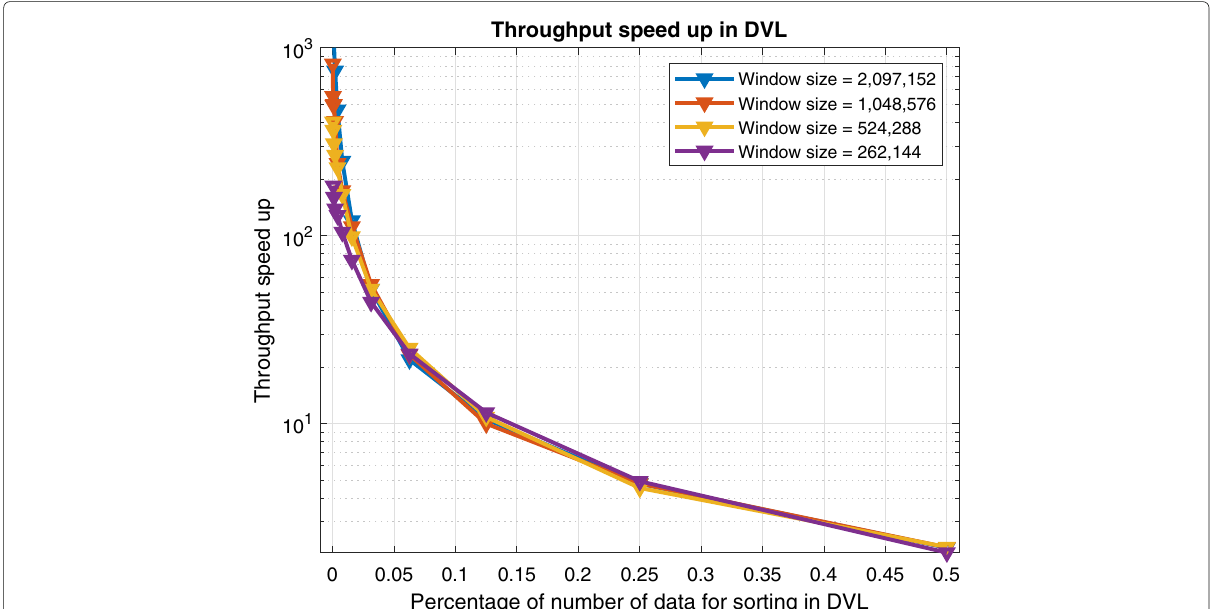
Fig. 3 Throughput speedup for the DVL actor for varying values of R